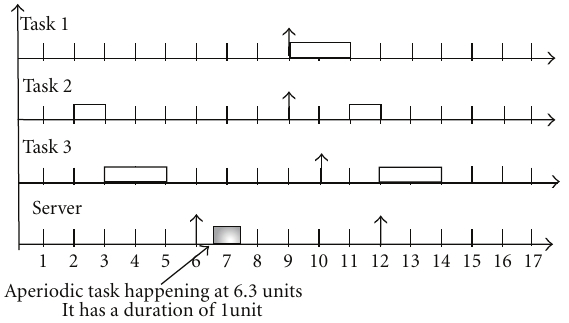
Figure 1: Related organization for PE with respect to Table 1.